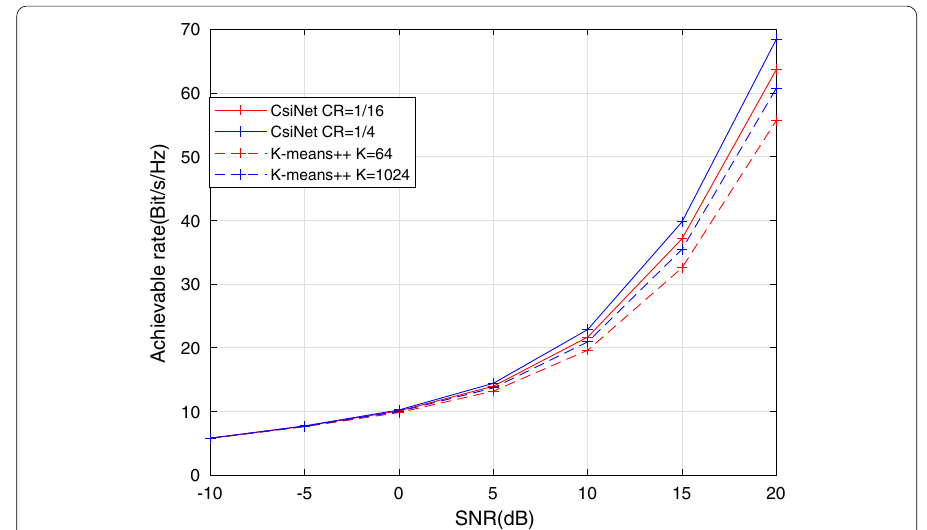
Fig. 6 Achievable rate performance of proposed codebook and CsiNet with different r c